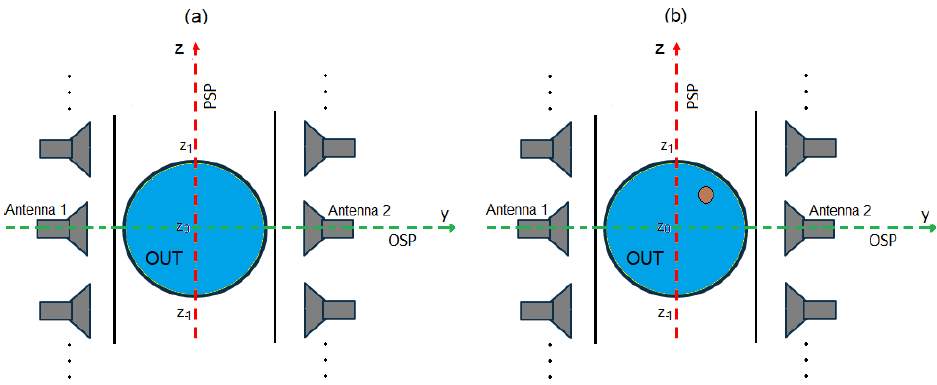
Figure 2. Symmetries exploited by the proposed detection/imaging approaches: ( a ) the OUT is free of inclusions; ( b ): the OUT presents an inclusion so that the symmetry is lost.